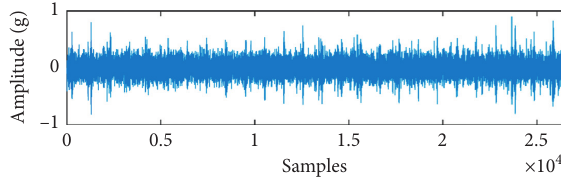
Figure 23: The angular signal of inner race fault.